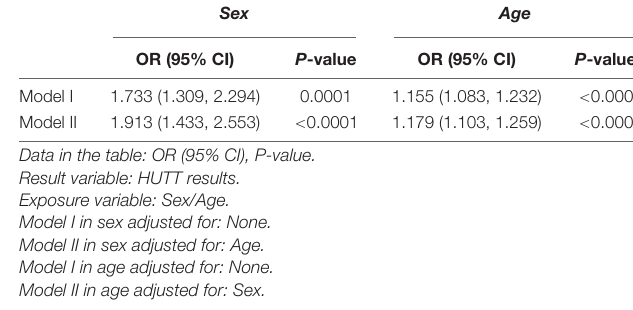
TABLE 4 | The relationship between age and HUTT results and the relationship between sex and HUTT in different models. Sex Age OR (95% CI) P -value OR (95% CI)